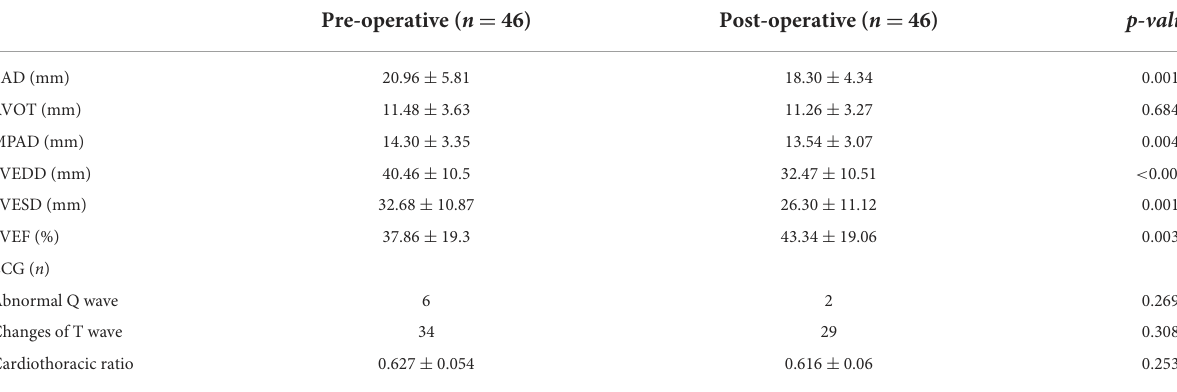
TABLE 3 Comparison between pre- and post-operative